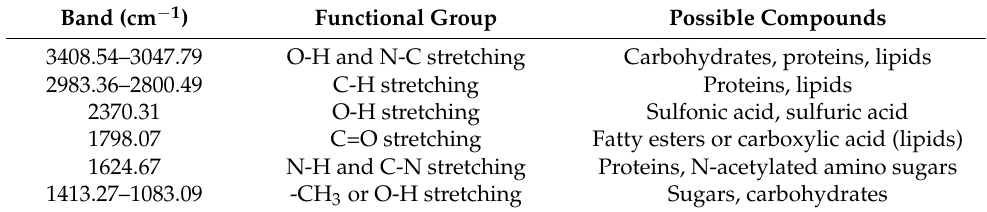
Table 9. Assignment of infrared bands identified in the EPS